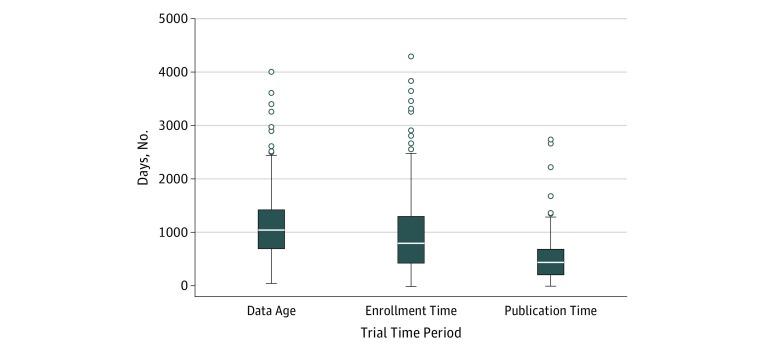
Distributions of Data Age, Enrollment Time, and Publication TimeThe ends of the boxes indicate the upper and lower quartiles, so the box spans the interquartile range. The middle line indicates the median, the whiskers are the 2 lines outside the box that extend to the highest and lowest observations, and the circles indicate the extreme values of the observations.